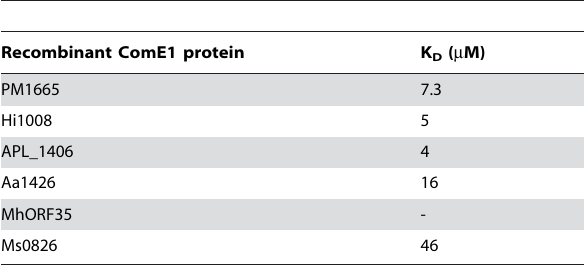
Table 3. K D values for the interaction of recombinant ComE1 proteins with pUC19.